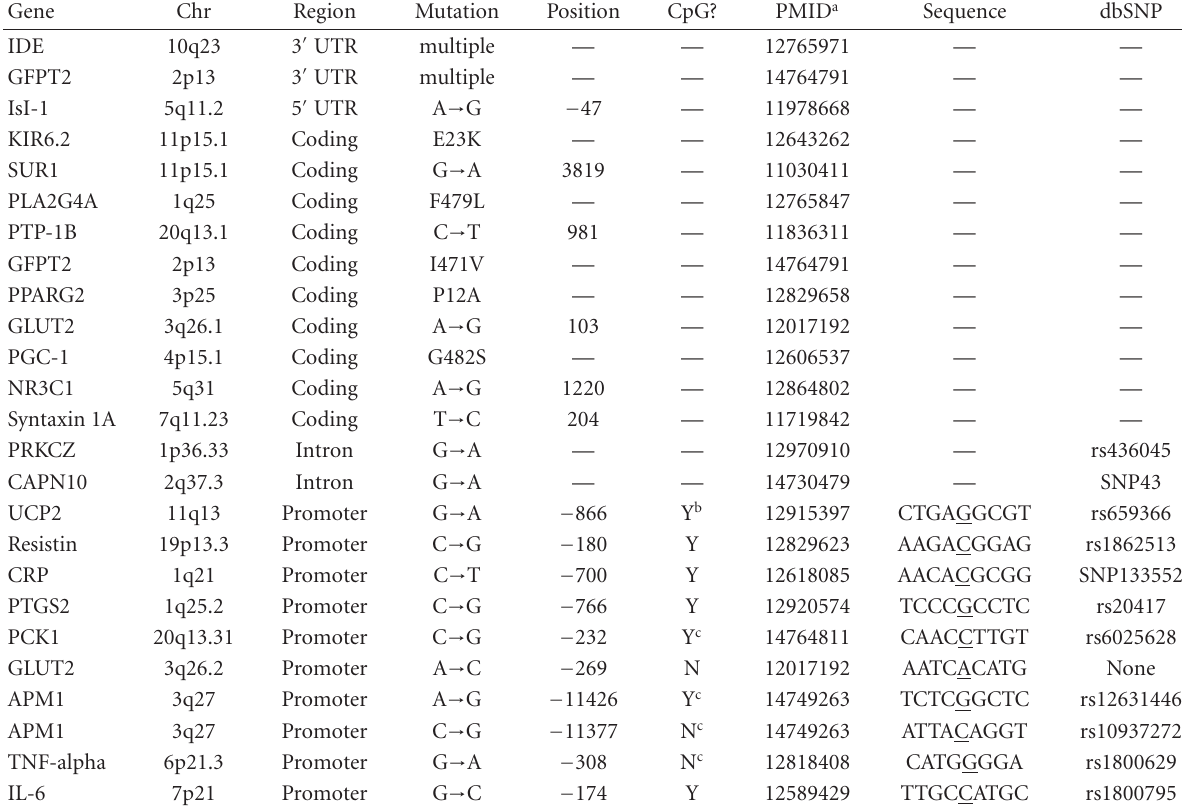
Table 1. A nonexhaustive list of SNP studies that have reported finding a “significant” association between one or more SNPs and a cohort of T2DM patients. NCBI’s sequence viewer was used to obtain flanking sequence. a denotes PMID = PubMed ID of paper publishing the SNP. b denotes that C allele was also present. c means that no dbSNP entry was found in exact map position as given, but the closest dbSNP entries had the same alleles as published, so these were used